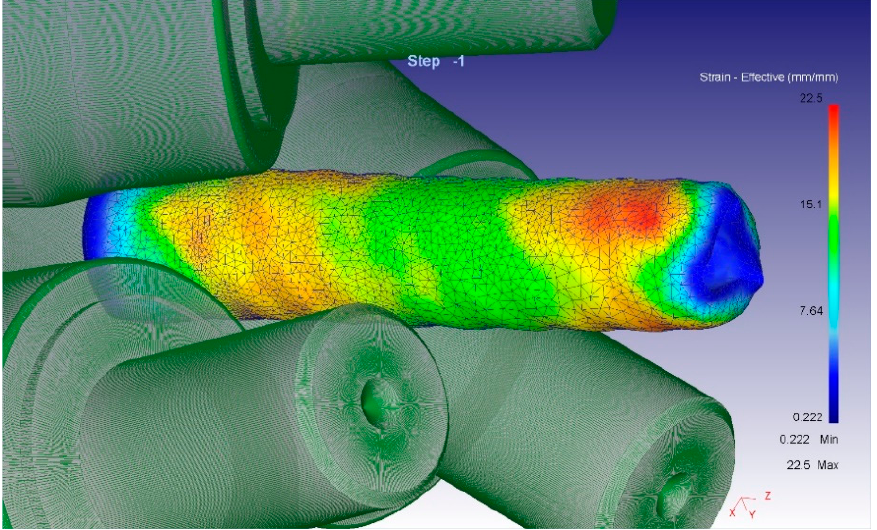
Figure 3. General sample view in equivalent strain colors and mesh in deformation zone after 37-30 mm of radial shear rolling at RSP-14/40 mill.